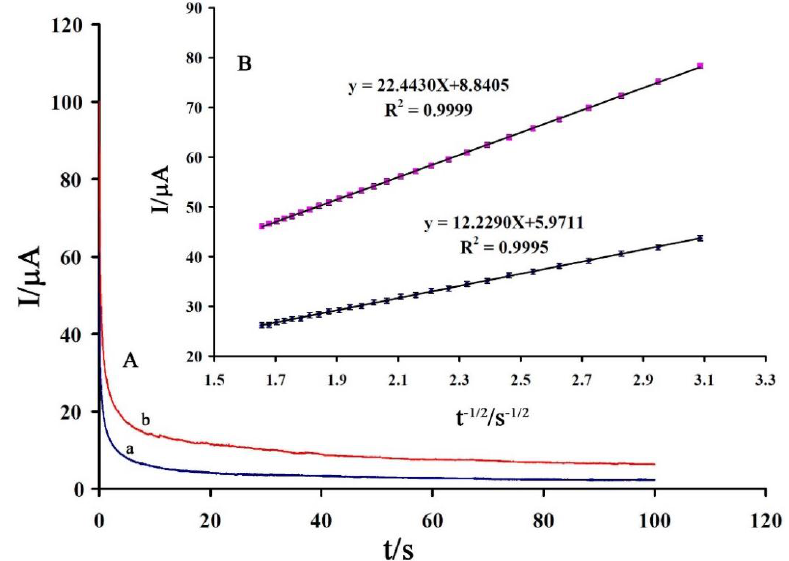
Figure 6. ( A ) Chronoamperograms obtained at 1,3-DIBr/ZnO/CNTs/CPE in the presence of (line a) 300 and (line b) 400 μM vitamin B 9 in the buffer solution (pH 9.0); ( B ) Cottrell plot for the data from the chronoamperograms.